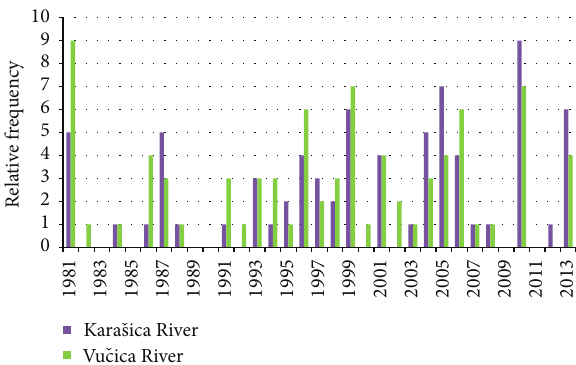
Figure 6: Flood events on the Karaˇsica and Vuˇcica Rivers in the period